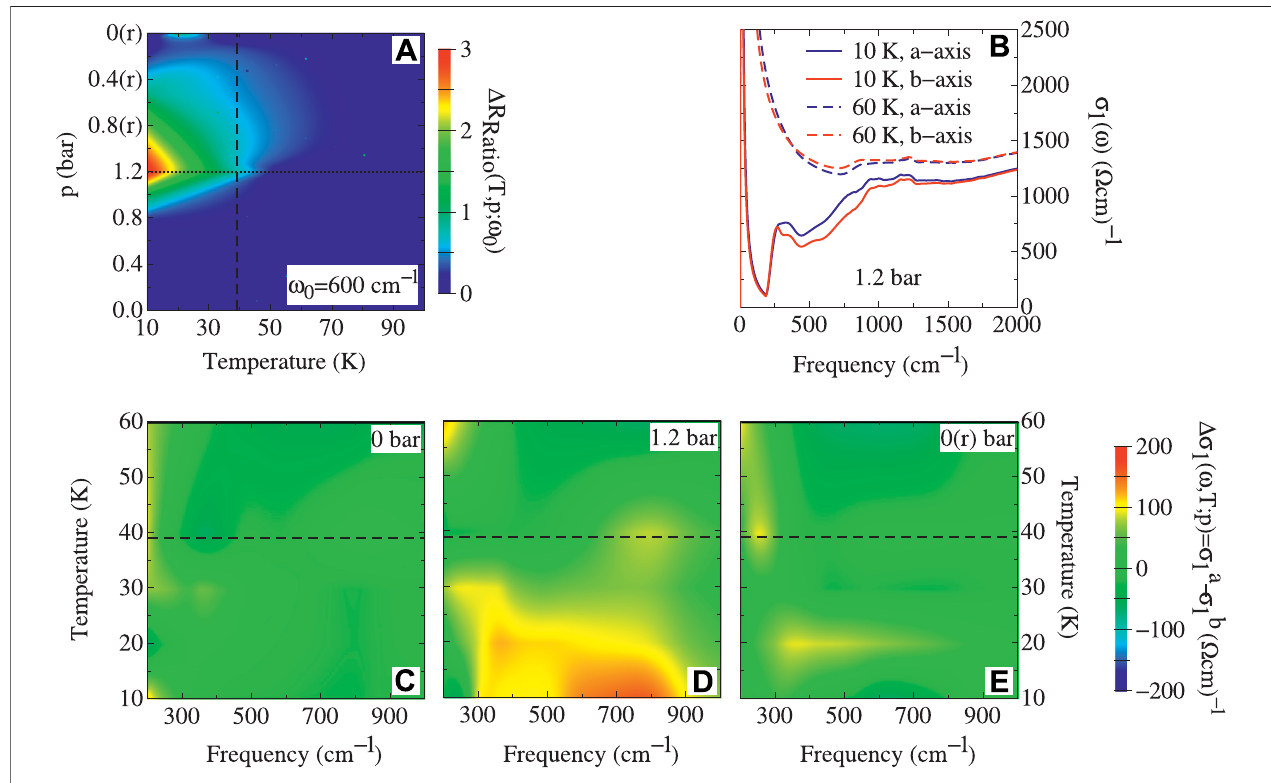
FIGURE 8 | (color online) (A) T dependence of the quantity Δ R Ratio ( ω 0 ) (see text) of Ba 0.6 K 0.4 Fe 2 As 2 within the p -loop experiment after a ZPC protocol, which emphasizesthe T evolutionofthe p -inducedopticalanisotropy.Wechoose ω 0 =600 cm − 1 .Thethickdottedlinemarks p =1.2 bar(i.e.,atsaturation). (B) Measured σ 1 ( ω ) at 10 K (i.e., T < T c ) and 60 K (i.e., T > T c ) for p = 1.2 bar along both crystallographic axes. (C,E) T dependence of Δ σ 1 ( ω ) at the selected p of 0, 1.2 and released 0 bar. ThesepanelsfocustheattentiontotheFIRenergyinterval200 – 1,000 cm − 1 ,thusemphasisingthereversibleopticalanisotropyuponsweeping p .Thethickdashed lineinpanels (A) and (C – E) indicates T c .A fi rst-neighborinterpolationprocedureisusedinordertogeneratethecolormaps.Released p isdenotedby “ (r) ” .Reproduced from Ref.